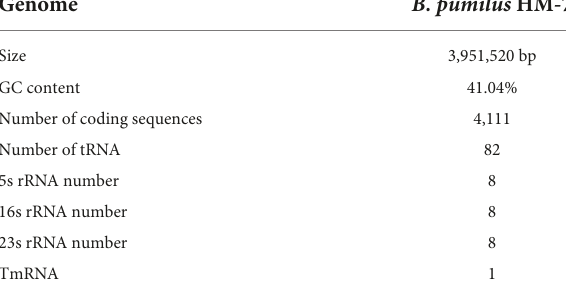
TABLE 1 General features of the B. pumilus HM-7